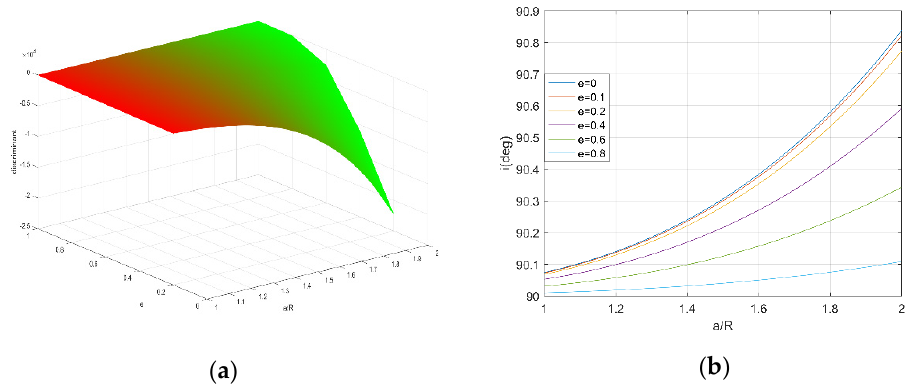
Figure 4. ( a ) Variation of the discriminant with respect to a and e ; ( b ) variations of the inclination i as the semi-major axis a increases from R to 2 R .